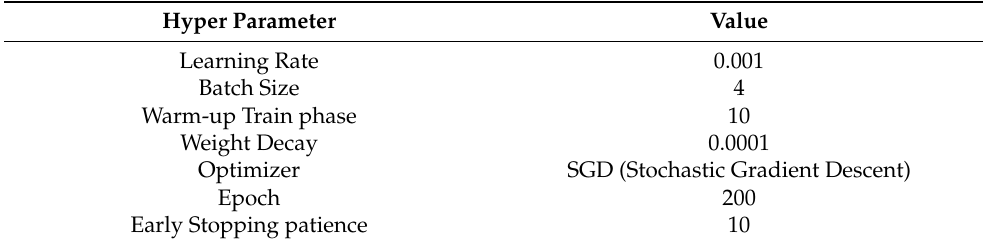
Table 2. Hyperparameters used in model